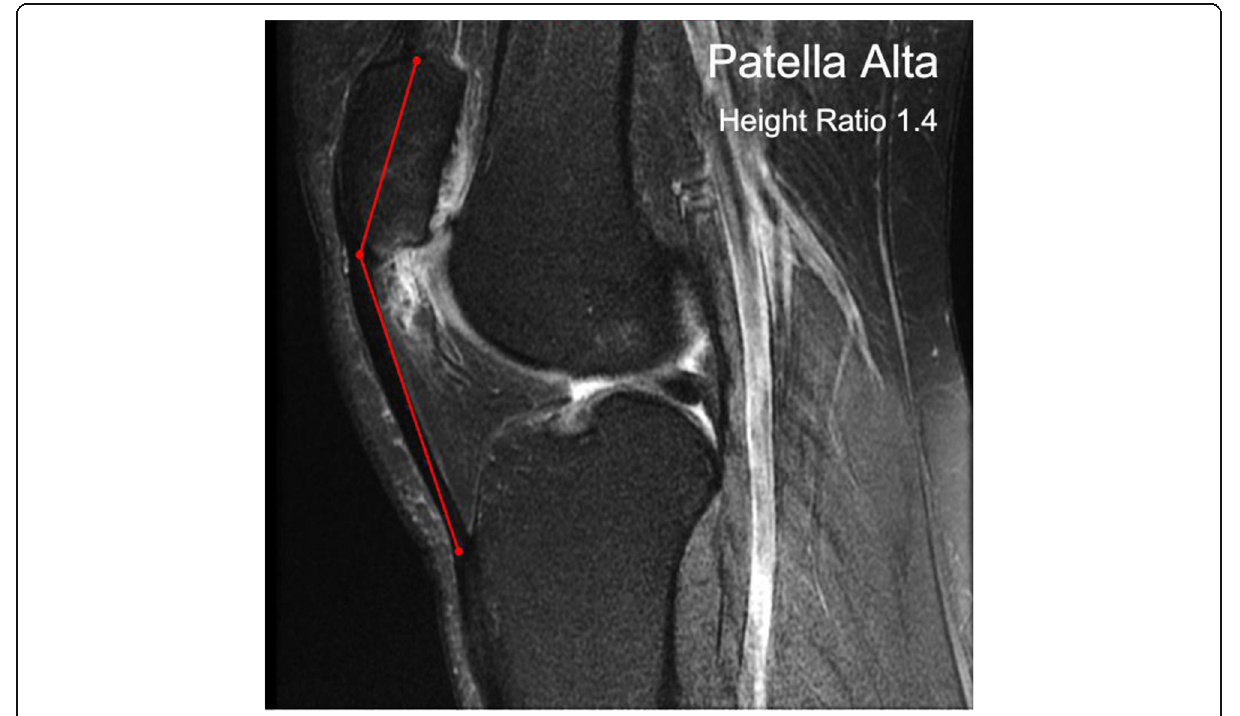
Fig. 1 MRI image in sagittal STIR demonstrated how to assess the patella alta depending on Insall – Salvati ratio